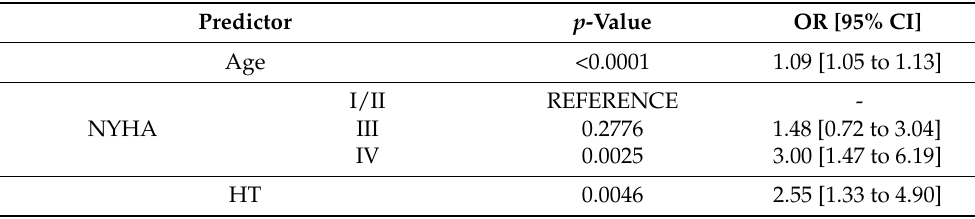
Table 3. Independent redictors of mortality in patients with HFpEF.